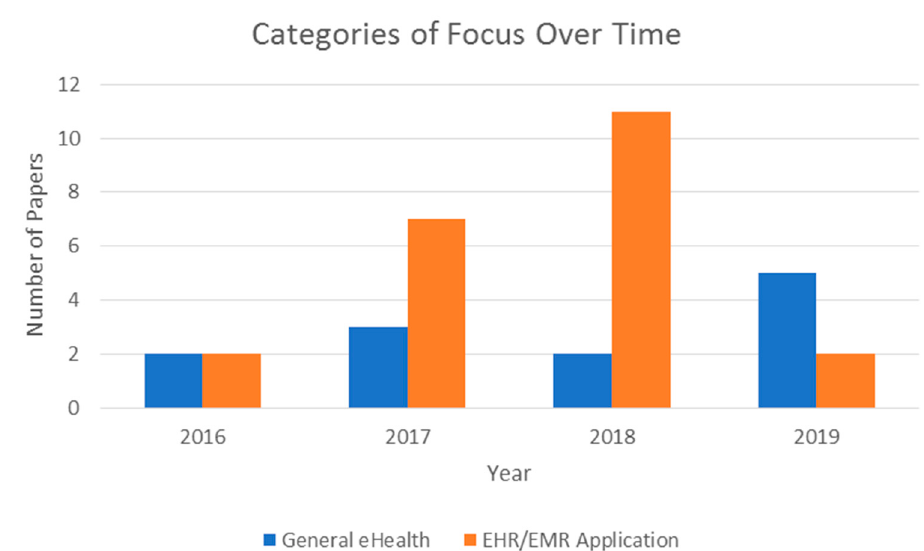
Figure 5. Comparison of focus between general eHealth topics and EHR/EMR applications over time.